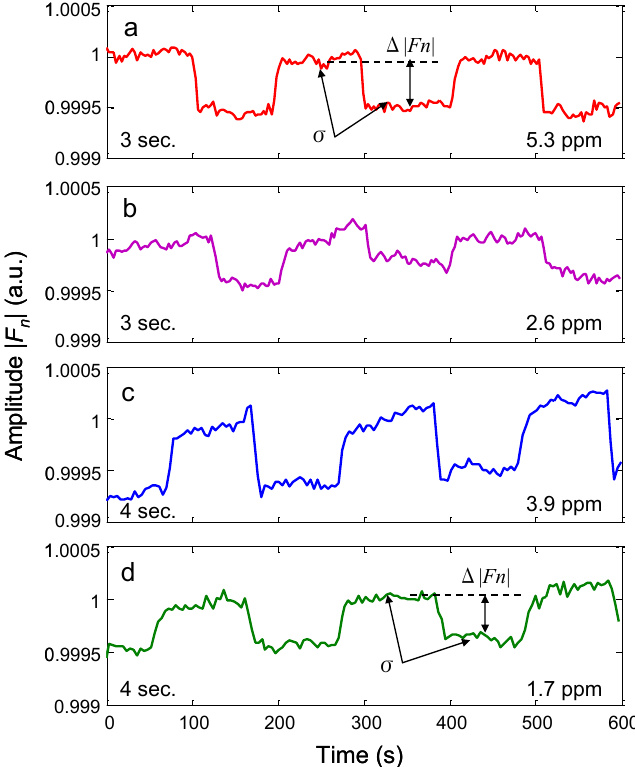
Figure 6. Detection effect on a 5.3 ppm methane ( a ) and a 2.6 ppm methane ( b ) with a 3 s sampling period. Detection effect on a 3.9 ppm methane ( c ) and a 1.7 ppm methane ( d ) with a 4 s sampling